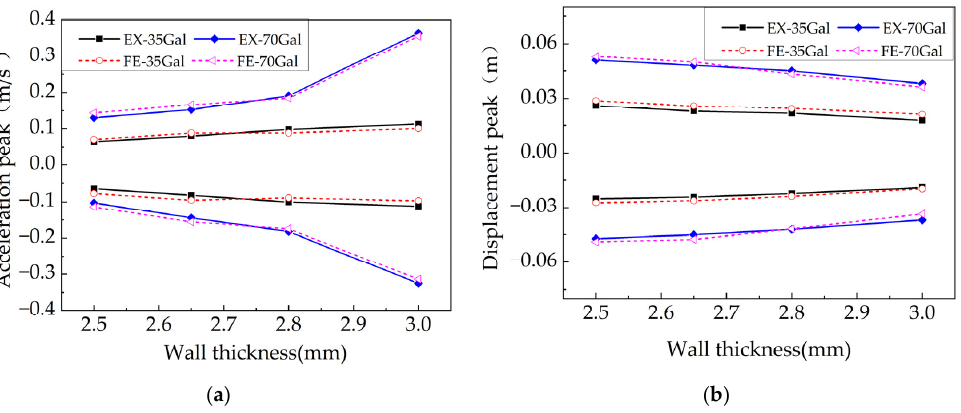
Figure 34. Comparison under the Hyogoken-Nanbu earthquake: ( a ) Comparison of acceleration peak; ( b ) Comparison of displacement peak.